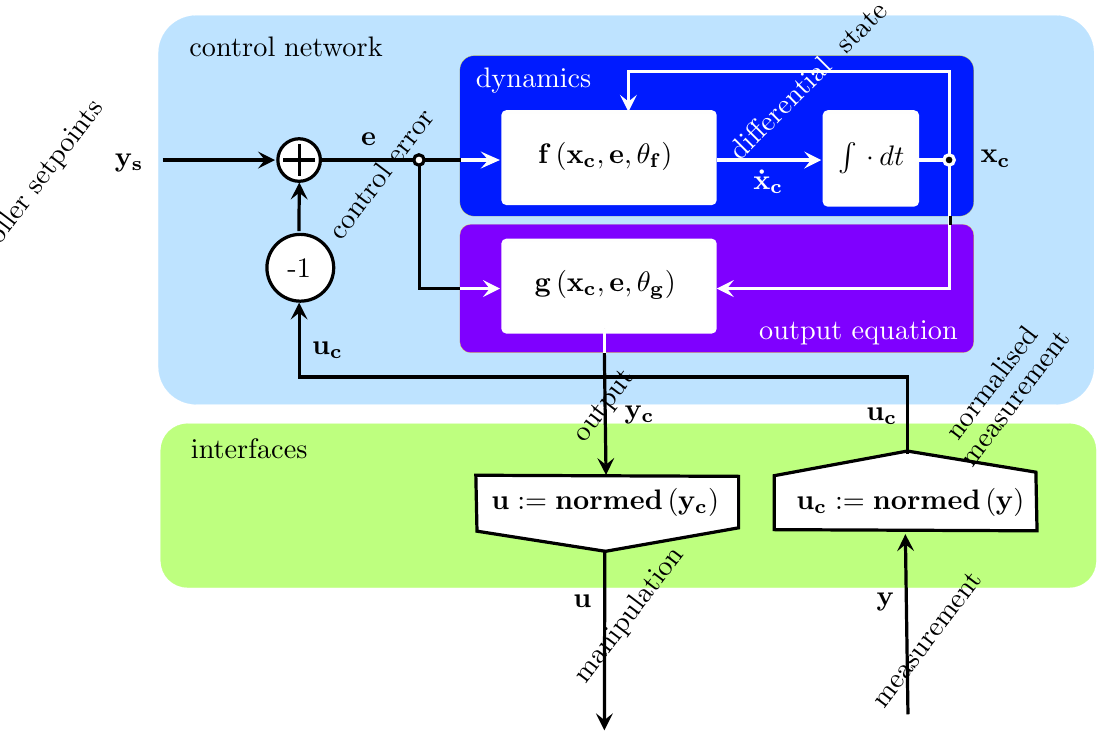
Figure 3. A generic control